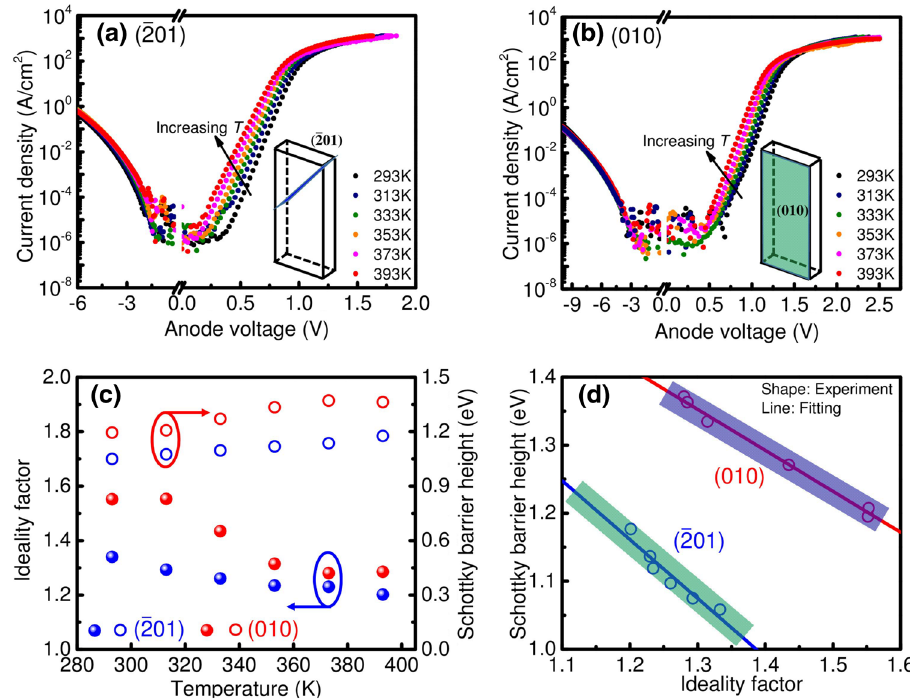
Fig. 5 Temperature-dependent I – V characteristics for a ( 2 01) β -Ga and SBH as a function of temperature, and d SBH versus ideality factor